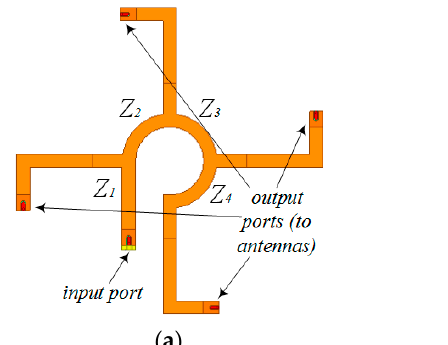
Figure 2. Representation of antenna array feed networks: ( a ) one level and ( b ) two levels of sequential rotation (SR).